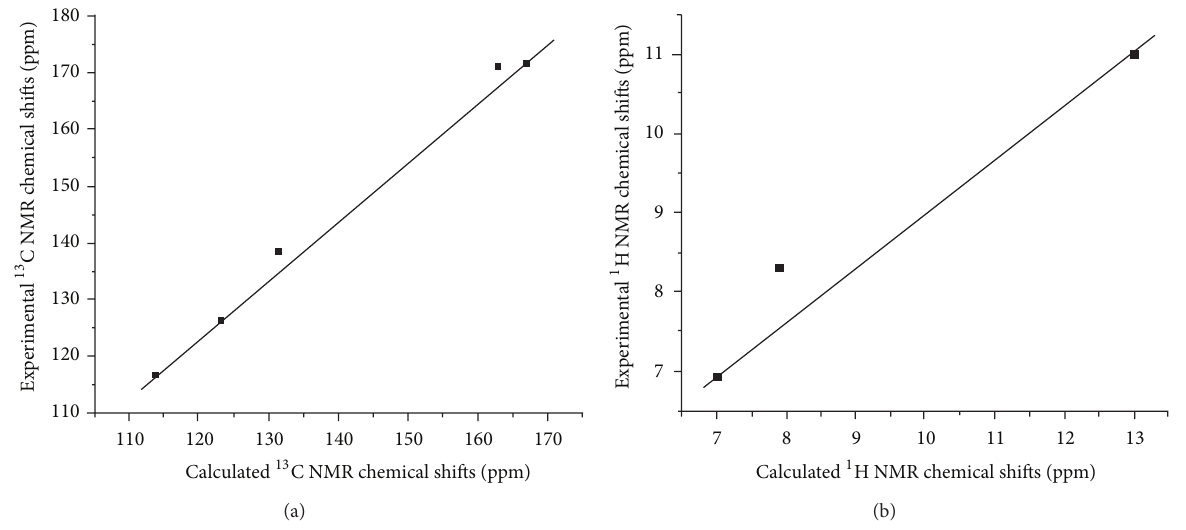
determining the zero-point vibration energies (ZPVE) and (𝑇) . The total energies and the change in the entropy 𝑆 vib the total entropy at room temperature using B3LYP/6-31G ∗∗ method are